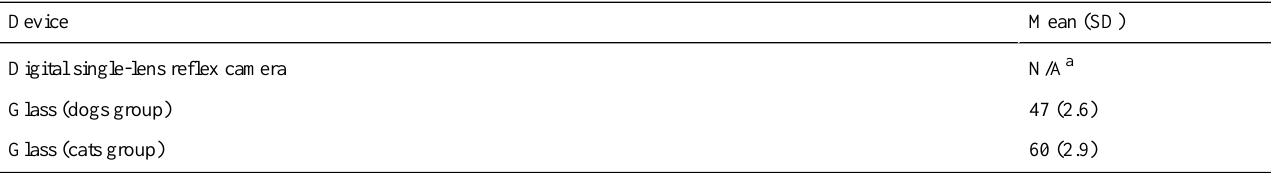
Table 5. Descriptive statistics of loss of battery consumption during forensic necropsy stratified by the device used to acquire the images: a Nikon D3200 reflex camera and the Google Glass